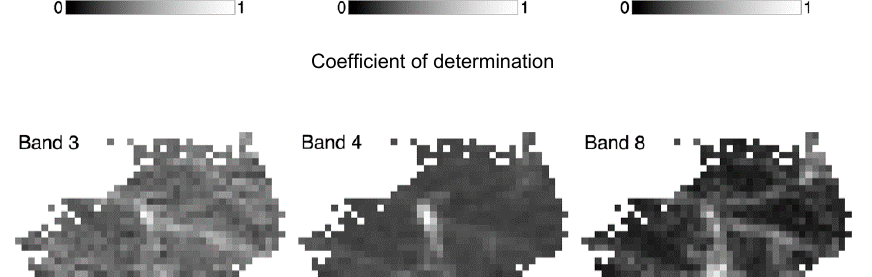
Figure 12. Coefficient of determination ( top ) and root mean square residual ( bottom ) of the pixel- based linear regression of reflectance against the sunlit fraction.